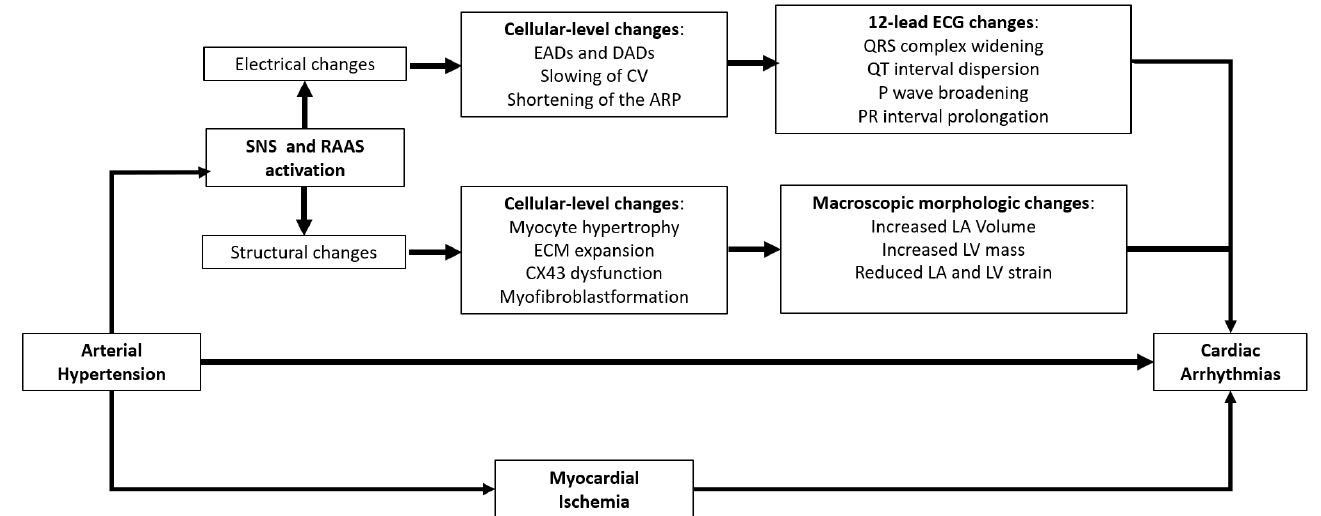
Figure 1. Electro-pathological and clinical changes occurring in hypertensive hearts. ARP, atrial refractory period; SNS, sympathetic nervous system; CV, conduction velocity; CX43, connexin 43; DADs, delayed afterdepolarizations; EADs, early afterdepolarizations; ECM, extracellular matrix; LA, left atrial; LA Vol, left atrial volume; LV, left ventricular; RAAS, renin–angiotensin–aldosterone system. See text for further details.